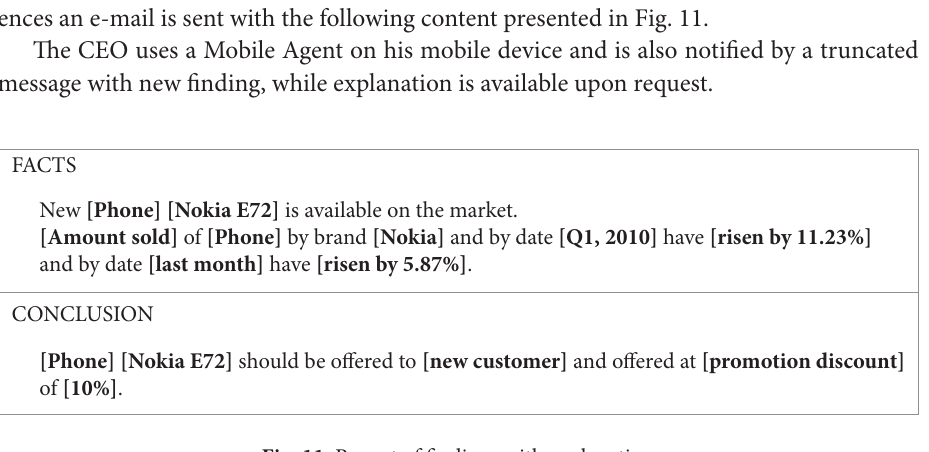
Fig. 11. Report of findings with